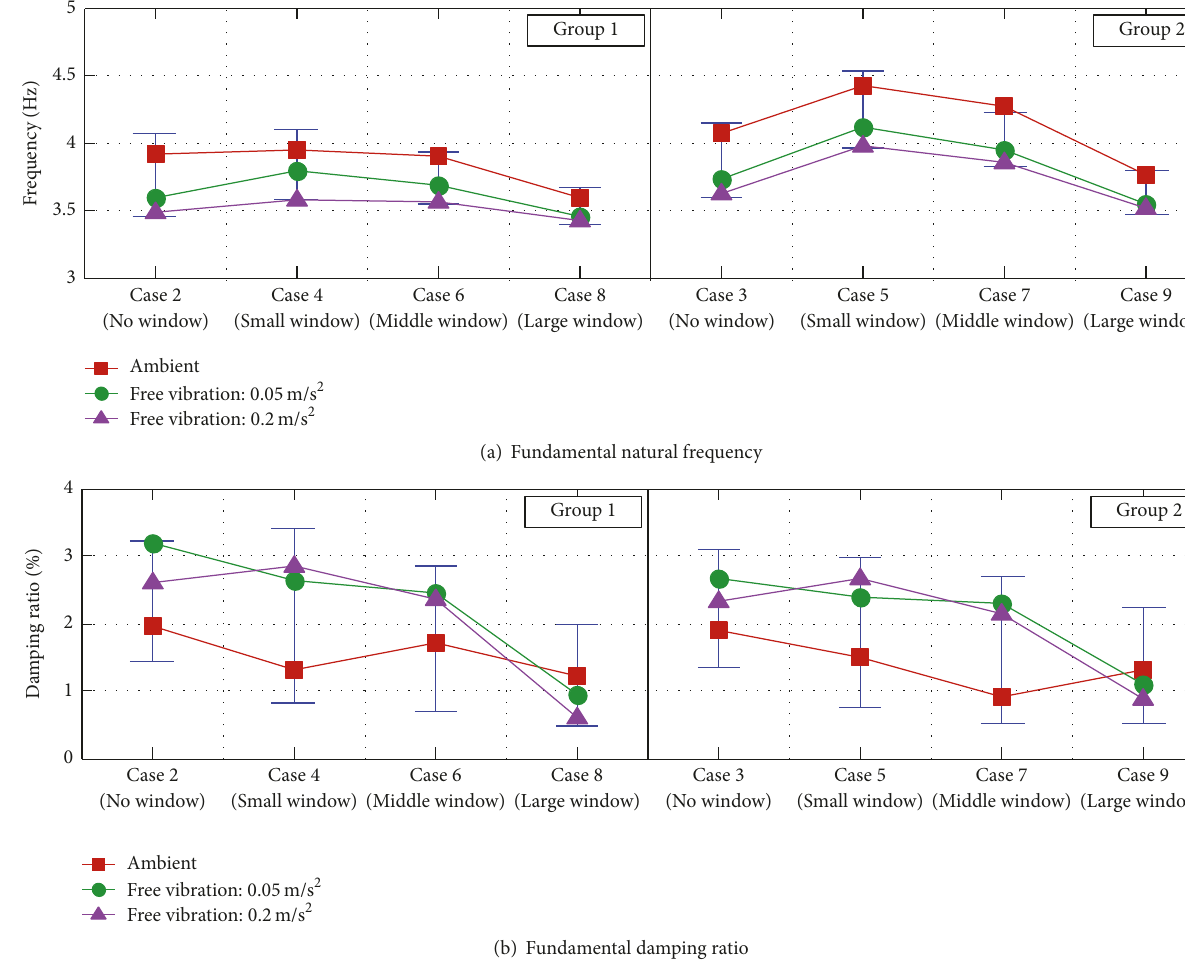
Figure 15: Effect of Window glazing systems on dynamic characteristics of steel frame.